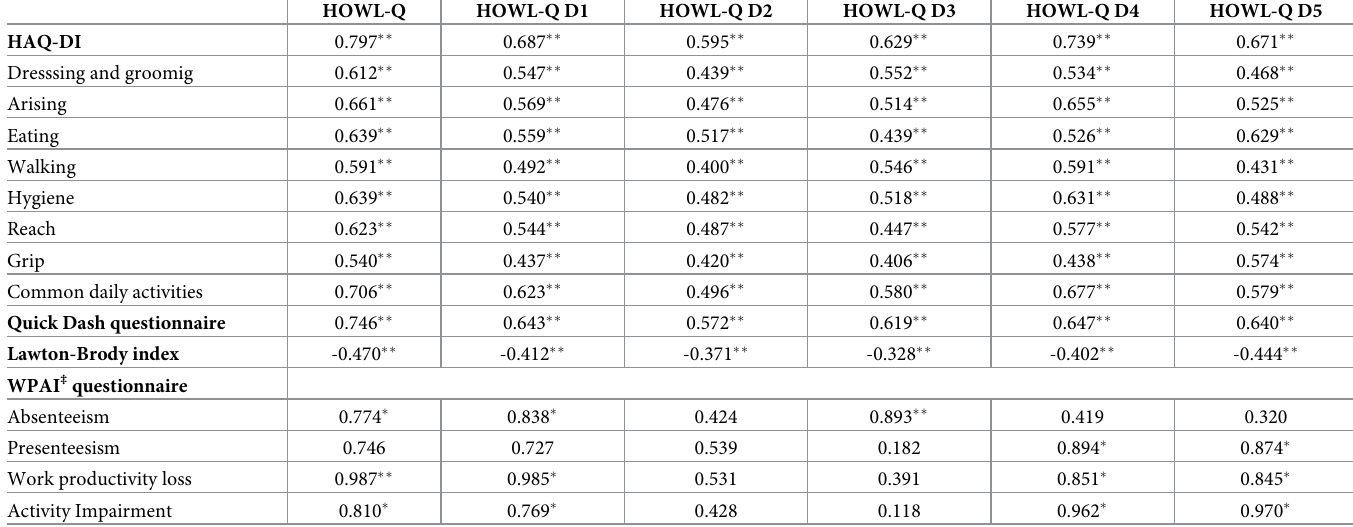
Table 6. Strength of the association between the HOWL-Q global score and individual dimensions scores, and the HAQ-DI, the Lawton-Brody Index, the Quick- DASH questionnaire and the WPAI questionnaire.